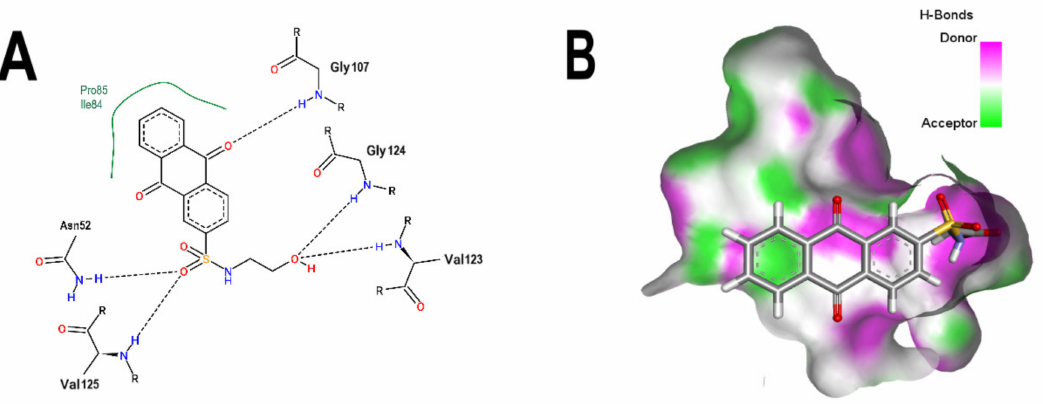
Figure 2. Analysis of the best pose of BS-1. ( A ) 2D interaction diagram of the 3ZKBL-BS-1 complex. ( B ) 3D representation of hydrogen bond surface of the 3ZKBL-BS-1 complex. 2D interaction diagram was performed with PoseView and 3D hydrogen bond surface representation was performed with Discovery Studio Visualizer.